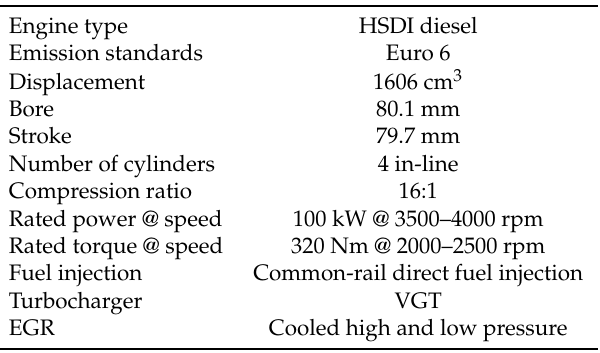
Table 1. Main characteristics of the engine.